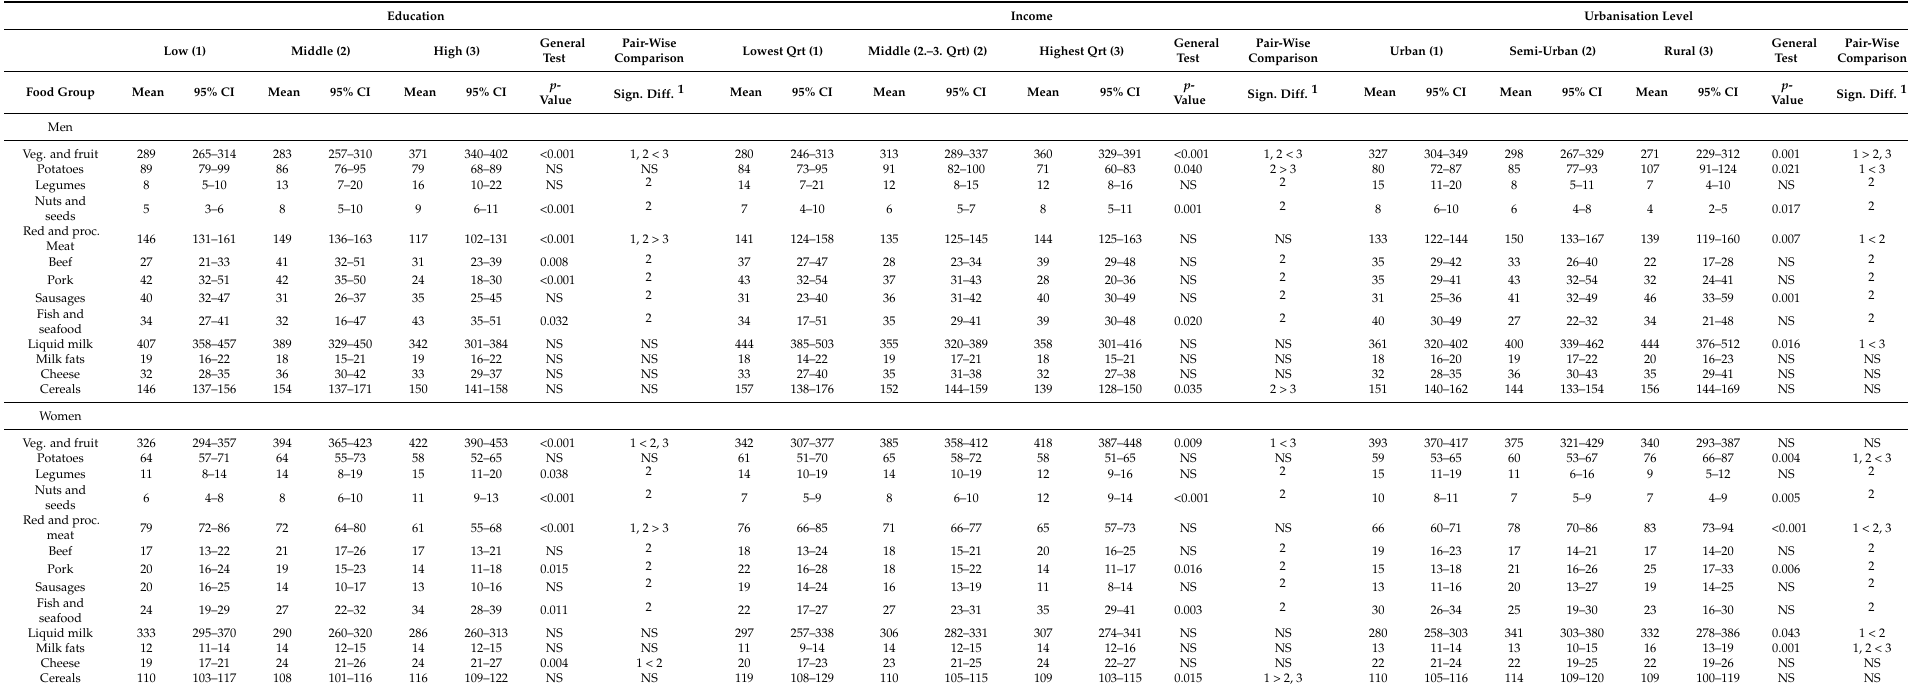
Table 2. Average consumption of food groups (g/day) in men and women by education, income and urbanisation